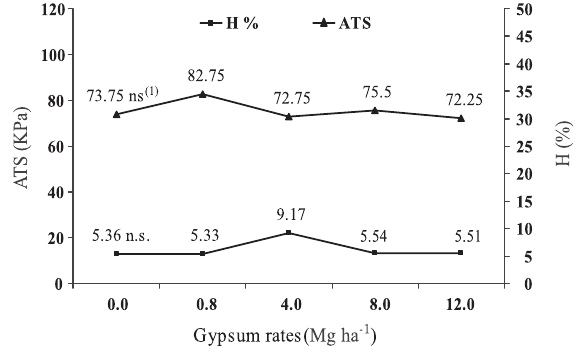
figure 1. aggregate tensile strength (atS) and gravimetric moisture (u) found in the layer 0.00–0.30 m of a no-tillage red latosol, 50 months after gypsum applications on the soil surface (guarapuava, 2009). (1) ns: non- significant by the aNoVa of the regression